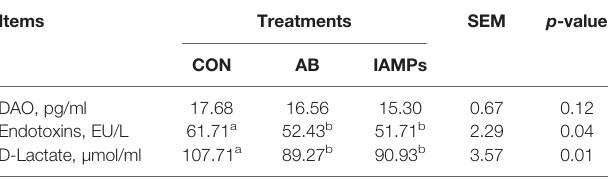
TABLE 6 | Effects of IAMPs on the concentrations of DAO, endotoxin, and diamine oxidase in serum of weaning piglets.